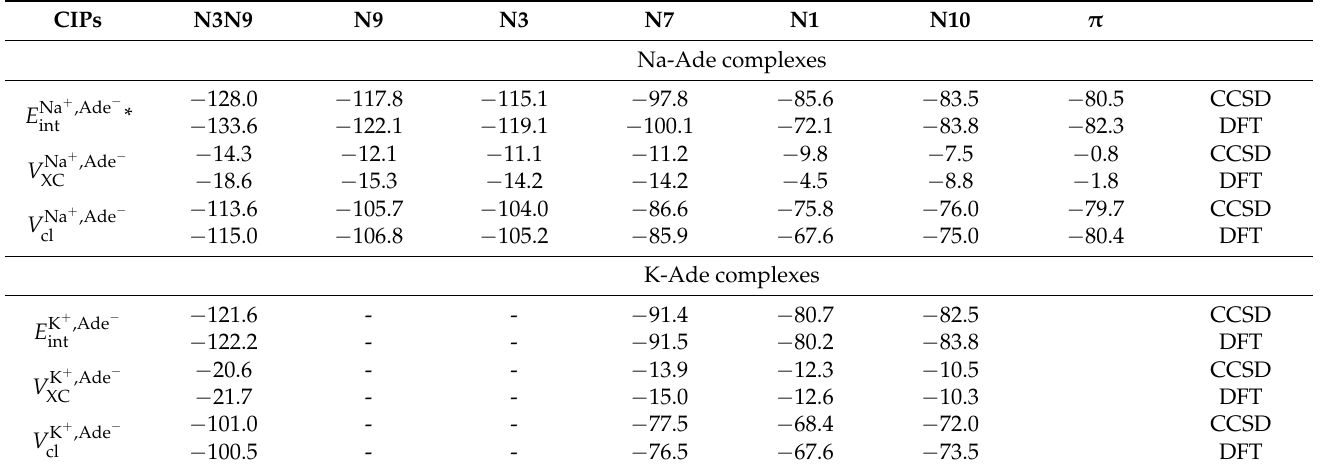
Table 1. The total inter-ionic interaction energy E M + ,Ade − V M